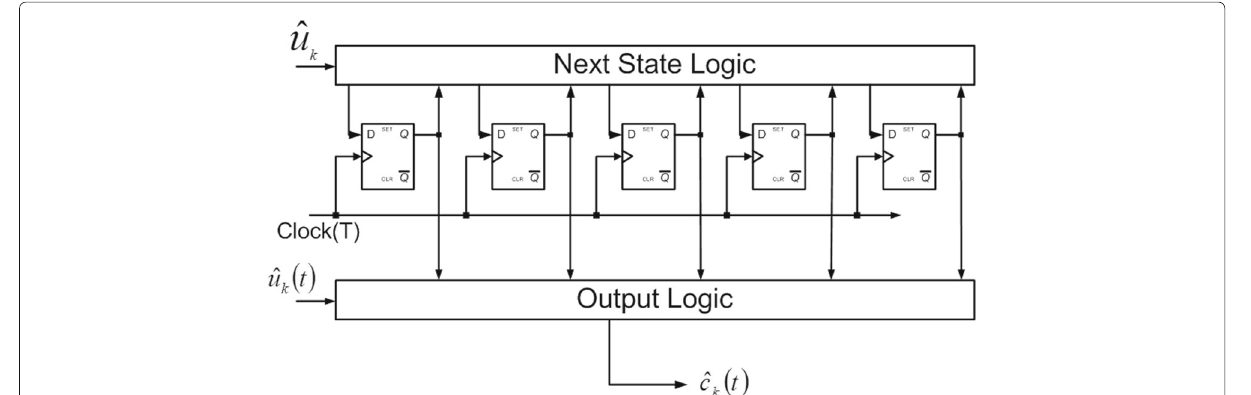
Fig. 4 The register-based hybrid encoder. This hybrid automaton allows the code word